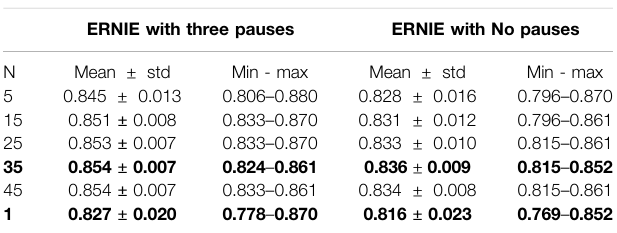
TABLE 3 | Ensemble also improves LOO for ERNIE (with and without pauses). LOO results are better with pauses than without, and better with ERNIE than